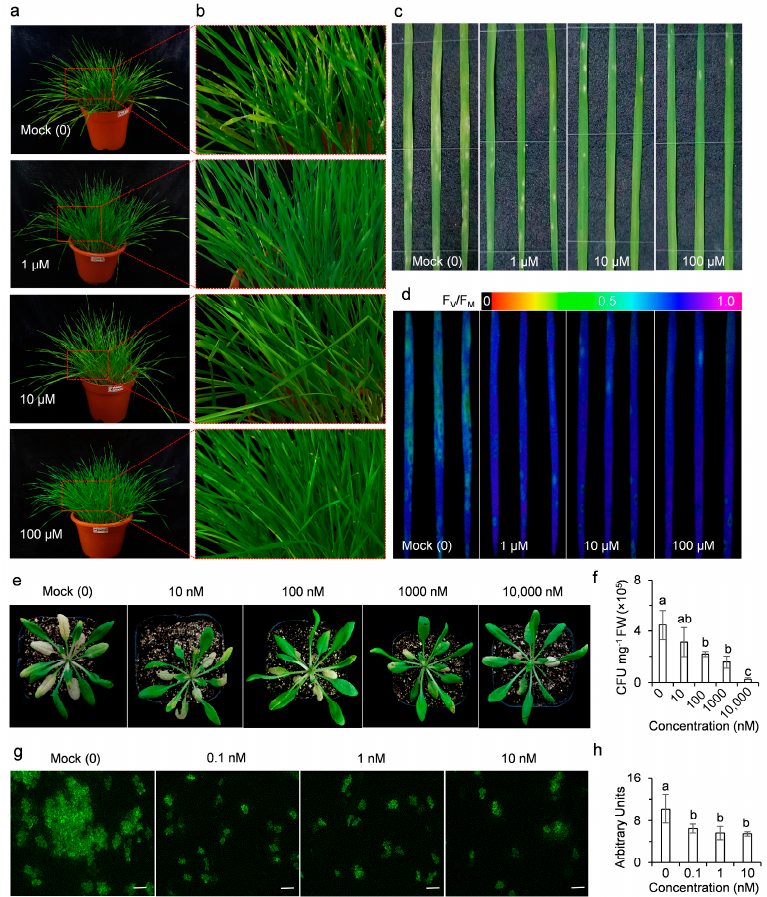
Figure 7. Induction of plant defense against pathogen attack by AMHA. Images of seedlings correspond to representative individuals from at least three independent biological replicates with similar results. ( a – d ) Pretreatment of AMHA confers resistance to powdery mildew in wheat. After pretreatment with water containing 0.02% Tween-20 (mock) or different concentrations of AMHA (1, 10 and 100 μ M) containing 0.02% Tween-20, wheat seedlings were inoculated with conidia of Blumeria graminis f. sp. tritici ( Bgt ). Disease symptoms of wheat plants ( a ) and the indicated red pane parts ( b ) after inoculation for 8 d. Macroscopic infection phenotypes ( c ) and chlorophyll fluorescence images of F V /F M ( d ) of representative leaves 8 d after inoculation of whole wheat plants with Bgt . Fluorescence images are color-coded based on the scale shown above the images. ( e , f ) Pretreatment of AMHA confers resistance to bacterial Pst DC3000 in Arabidopsis . After pretreatment with water containing 0.02% Tween-20 (mock) or different concentrations of AMHA (10, 100, 1000 and 10,000 nM) containing 0.02% Tween-20, Arabidopsis plants were inoculated with Pst DC3000. Disease symptoms developed by Arabidopsis plants 7 d after inoculation with Pst DC3000 ( e ). Concentration of bacteria in fresh leaves after 4 d inoculation of whole plants with Pst DC3000 ( f ). ( g , h ) Pretreatment of AMHA confers resistance of tobacco to TSWV. After pretreatment with water containing 0.02% Tween-20, tobacco leaves were infiltrated with Agrobacterium -mediated TSWV carrying SR (+)eGFP + M ( − )opt + L (+)opt constructs in vivo. eGFP fluorescence expression in tobacco leaves was visualized by a fluorescence microscope at 7 d ( g ) and quantified ( h ) to determine the amount of TSWV in the infected leaves. Scale bar = 200 µ m. Results in F and H represent mean values ± SD of three independent biological replicates. Different small letters above error bars indicate significance at 0.05